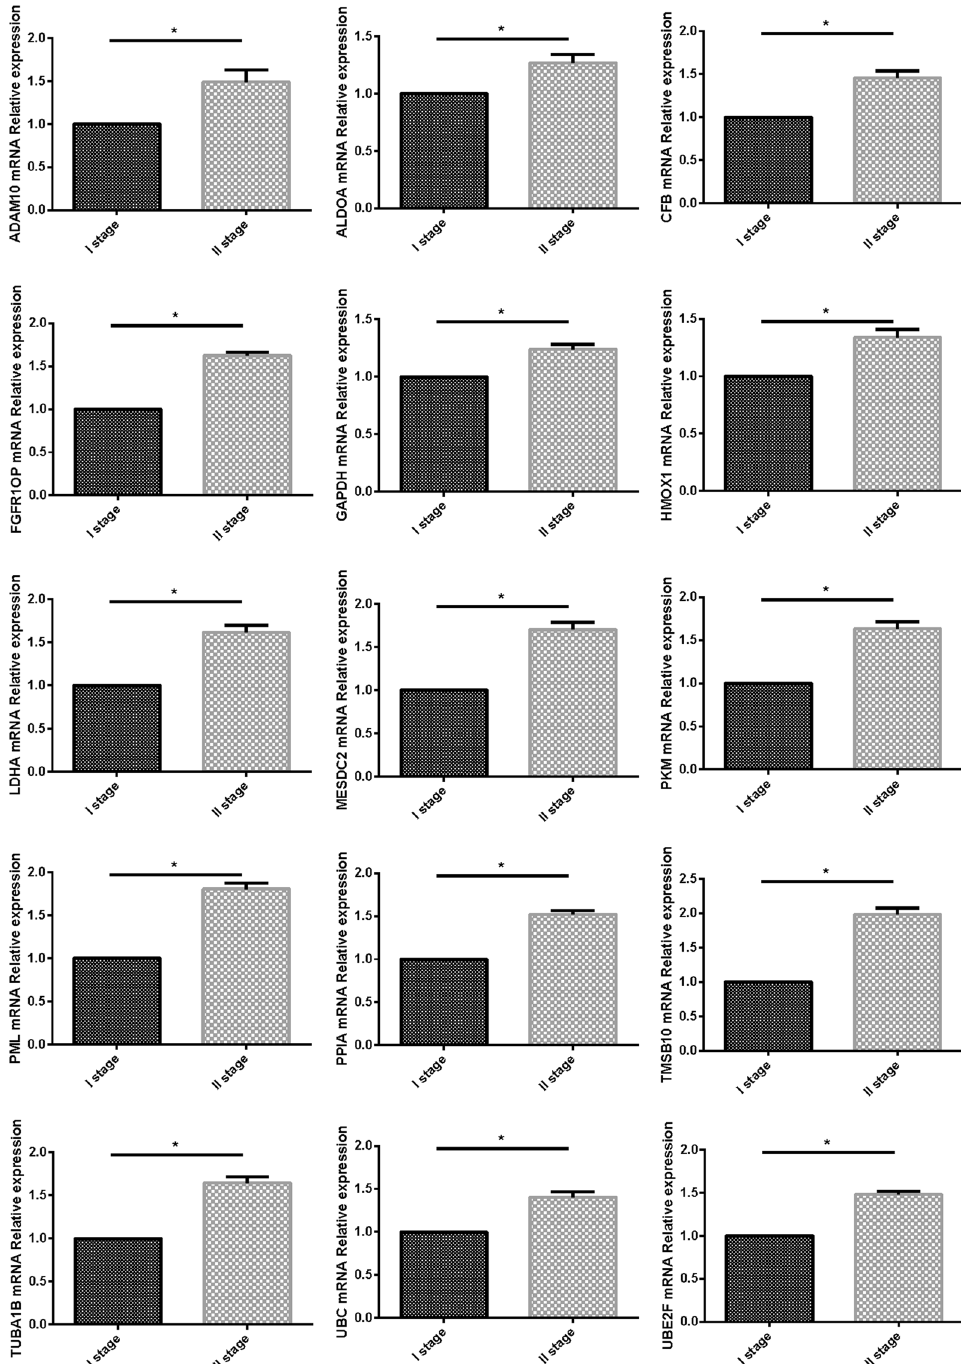
Figure 12. The expression of 15 mRNAs detected by RT-PCR. 15 mRNAs was significantly higher in stage II NSCLC than in stage I ( P <